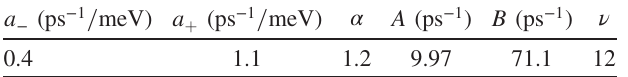
TABLE II. Scattering rate parameters used in Eqs. (4) and (A5) to calculate the Seebeck coefficients in Fig. 8. The value of ν is derived from the angle-dependent magnetoresistance and is explained in more detail in the Methods section in Ref.